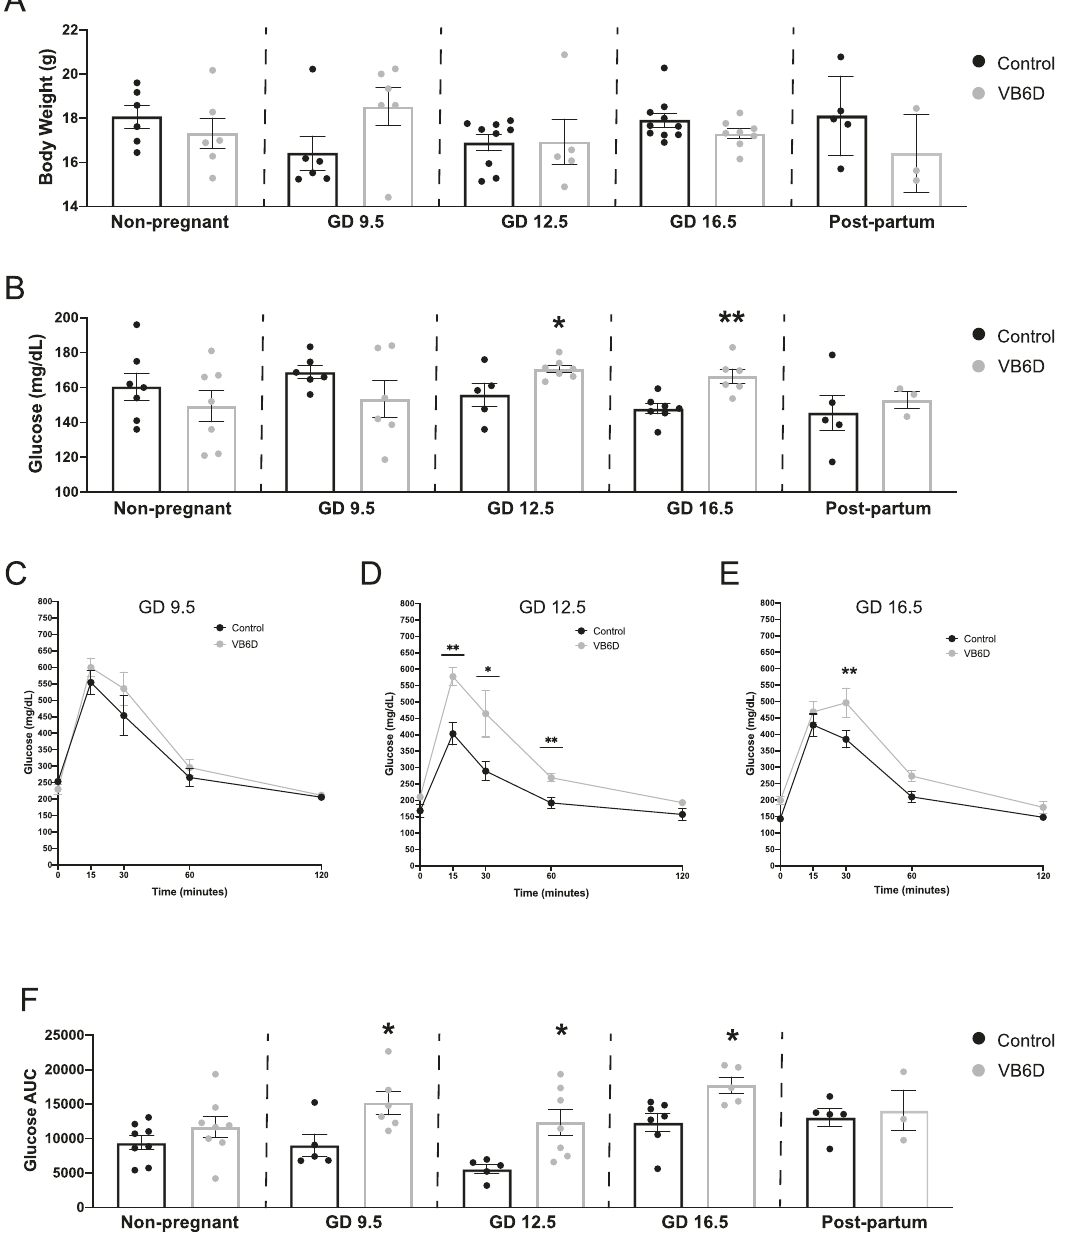
Fig. 1 Vitamin B6 de fi ciency induces glucose intolerance during pregnancy. Body weights ( A ) and fasting glucose levels ( B ) were measured in control and vitamin B6 de fi cient (VB6D) non-pregnant, pregnant, and 3 weeks postpartum mice. Glucose time graphs are shown for each timepoint GD 9.5 ( C ), GD 12.5 ( D ), and GD 16.5 ( E ) in which VB6D dams are glucose intolerant. Glucose area under the curve (AUC) was elevated in VB6D mice only during pregnancy ( F ). Data represent 3 – 8 mice per treatment group. Analysis of panels A , B , and F were done by an unpaired, two-sided, t -test. Panels C – E by two-way, repeated-measures ANOVA. In panels D and E , diet × time interaction effect was observed, and post hoc Tukey ’ s tests were performed. * p ≤ 0.05, ** p ≤